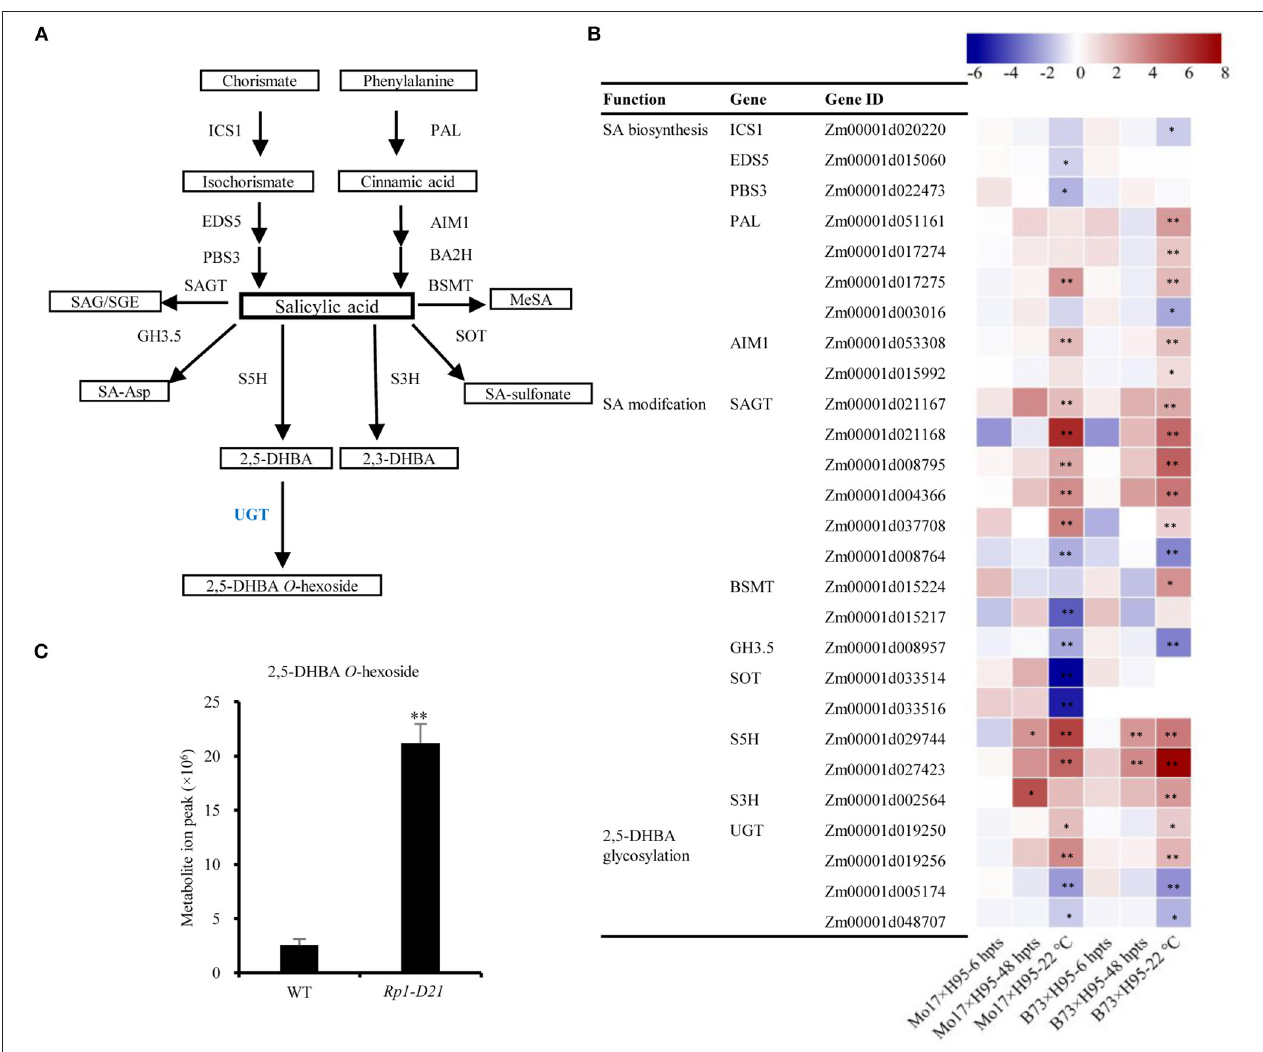
FIGURE 4 | The key enzymes involved in salicylic acid (SA) biosynthesis and modification pathways. (A) The SA biosynthesis and modification pathways. ICS1, isochorismate synthase 1; PAL, phenylalanine ammonia-lyase; EDS5, enhanced disease susceptibility 5; PBS3, AvrPphB susceptible3; AIM1, abnormal inflorescence meristem1; BA2H, benzoic acid 2-hydroxylase; UGT, UDP-glucosyltransferases; SAGT, salicylic acid glucosyltransferase; SAG, SA 2-O- β -Dglucoside; SGE, salicylate glucose ester; BSMT, benzoic acid/salicylic acid carboxyl methyltransferase; MeSA, methyl salicyliate; GH3.5, GH3 acyl adenylase family member 3.5; SA-Asp, salicyloyl-L-aspartate; SOT, sulfotransferase; S5H, SA 5-hydroxylase; S3H, SA 3-hydroxylase; 2,5-DHBA, 2,5-dihydroxybenzoic acid; 2,3-DHBA, 2,3-dihydroxybenzoic acid. (B) The log2 fold-change of the genes encoding key enzymes in SA biosynthesis and modification pathways. The fold change was normalized with the FPKM value. (C) The levels of 2,5-DHBA O -hexoside were significantly accumulated in Rp1-D21 mutant (mt) compared to the wild type (WT). Asterisks indicate significant difference between samples, each sample with three biological replicates.